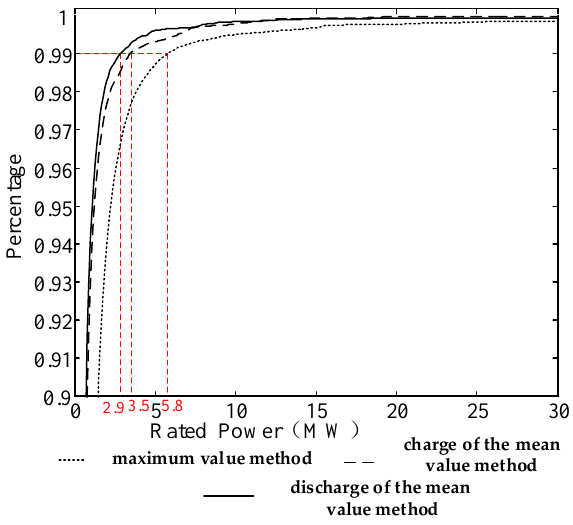
Figure 8. Cumulative probability distribution of the power of ESS using two strategies.